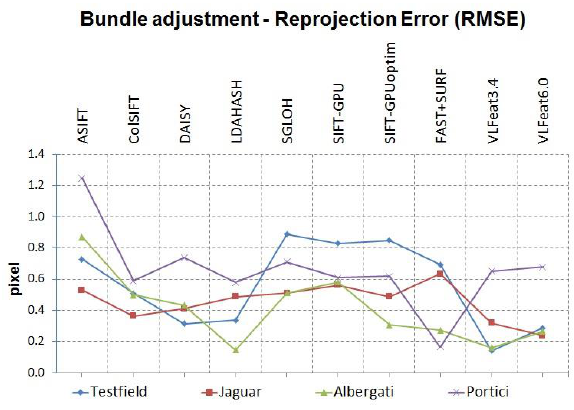
Figure 4: Results of the bundle adjustment for each dataset in terms of reprojection error. - visibility of 3D points in more than 3 images (Fig. 5): the results show that more than 50% of the triangulated points are visible at least in 3 images, although for highly overlapped images (Testfield and Jaguar) this might not be so significant. - average rays per 3D points (i.e. the redundancy of the computed 3D object coordinates): for the Jaguar and Testfield datasets the point multiplicity is shown in Fig. 6a and Fig. 7a. In comparison with the ground truth measurements and despite the high overlap of the images (almost 100% for the entire dataset), the feature-based methods show a low average multiplicity. - average intersection angles per 3D points : as 3D from